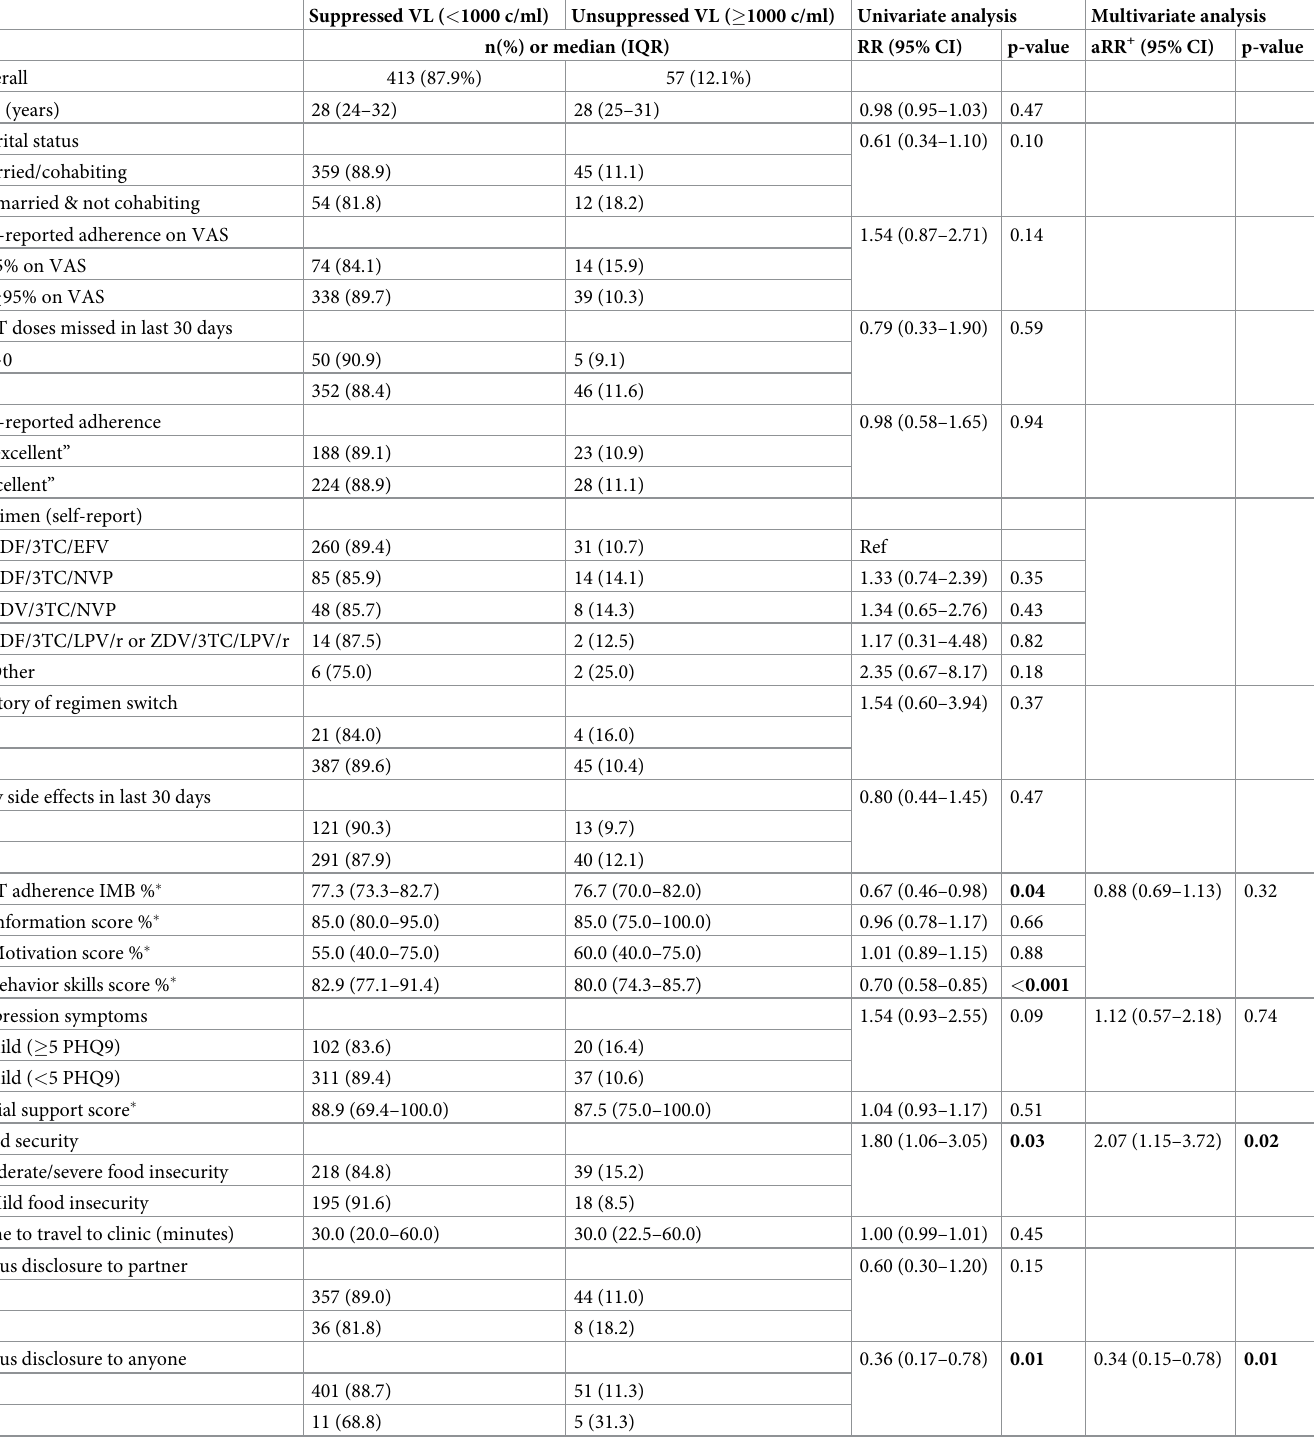
Table 1. Correlates of unsuppressed VL (among those on ART � 4